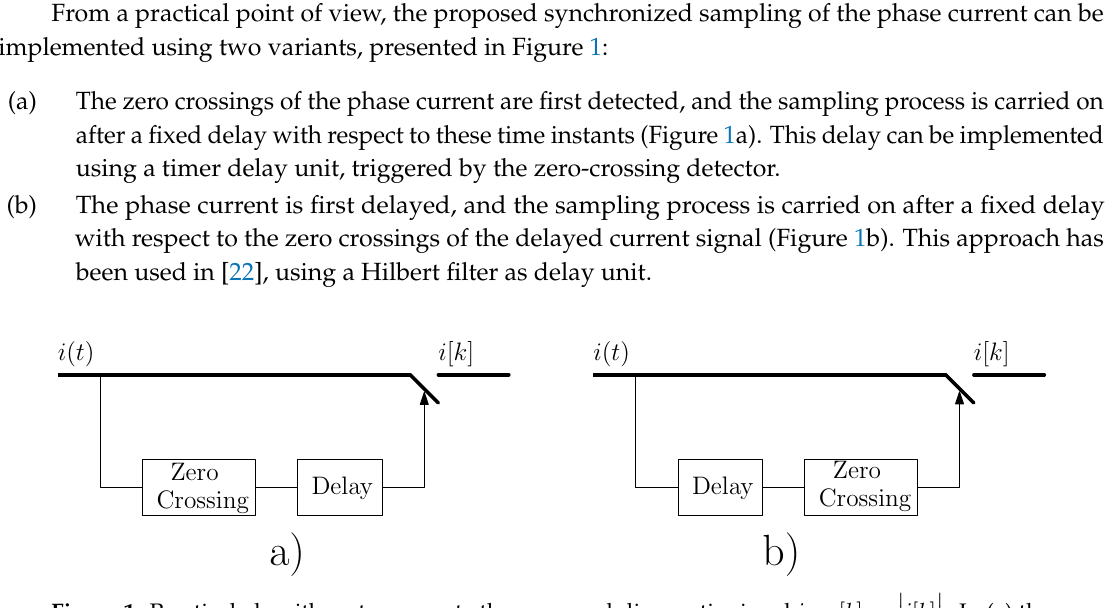
Figure 1. Practical algorithms to compute the proposed diagnostic signal i renv [ k ] = positive zero crossings of the current are first detected, and the sampling process is delayed from these time instants. In ( b ) the current signal is first delayed, and the sampling process is synchronized with the positive zero crossings of the delayed